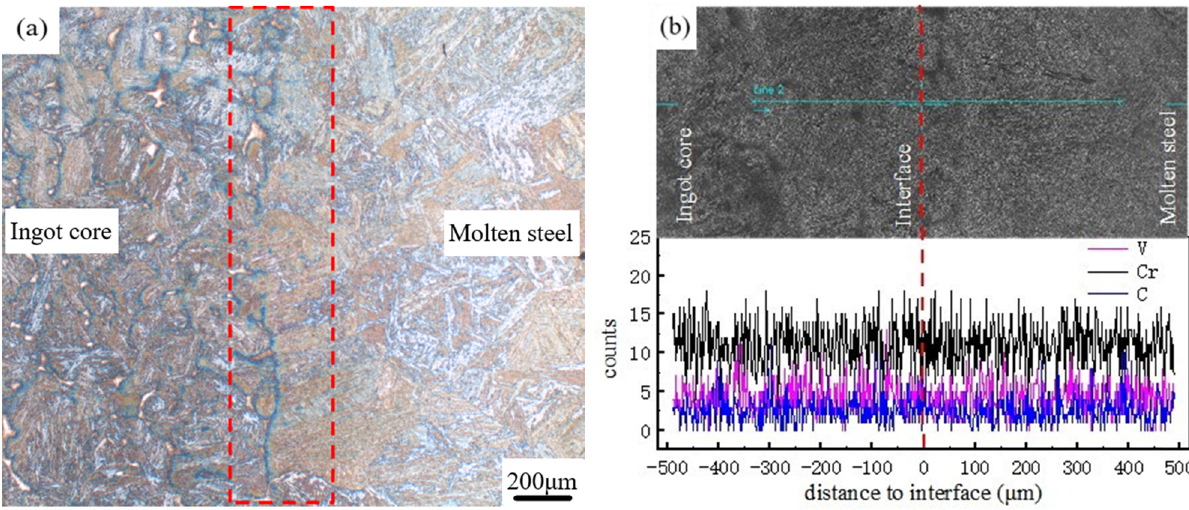
Figure 13: Metallographic structure and element distribution of solid – liquid interface in the middle of clad steel ingot: ( a ) interface metallographic structure; ( b ) interface element distribution.